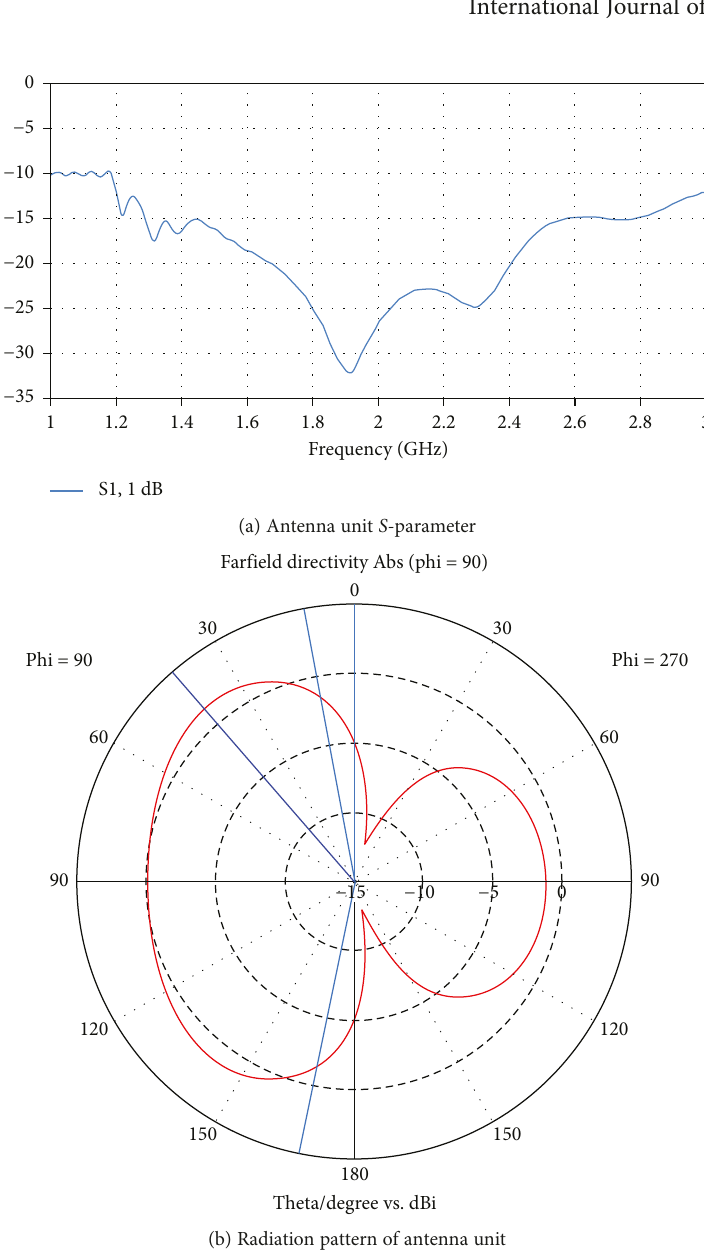
Figure 2: Diagram of the S -parameter and radiation